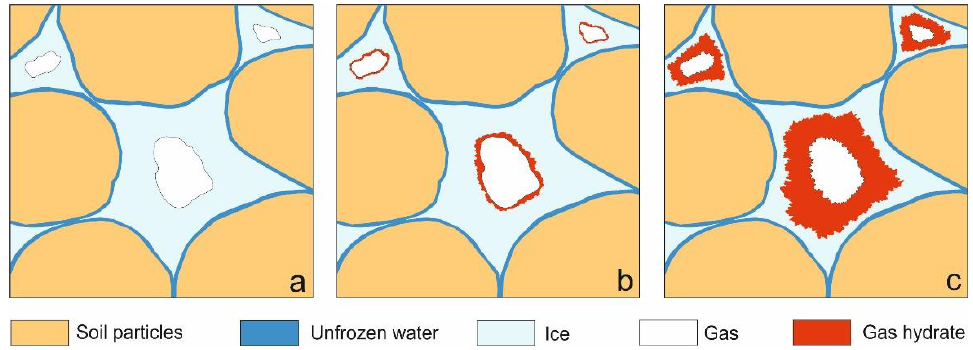
Figure 5. Nucleation and growth of pore gas hydrate particles in frozen gas-saturated soil samples. ( a ) Initial state (frozen gas-saturated soil, low ice saturation); ( b ) gas hydrate films at ice-gas interface; and ( c ) blocked gas-ice contact and transition to volumetric-diffusion hydrate